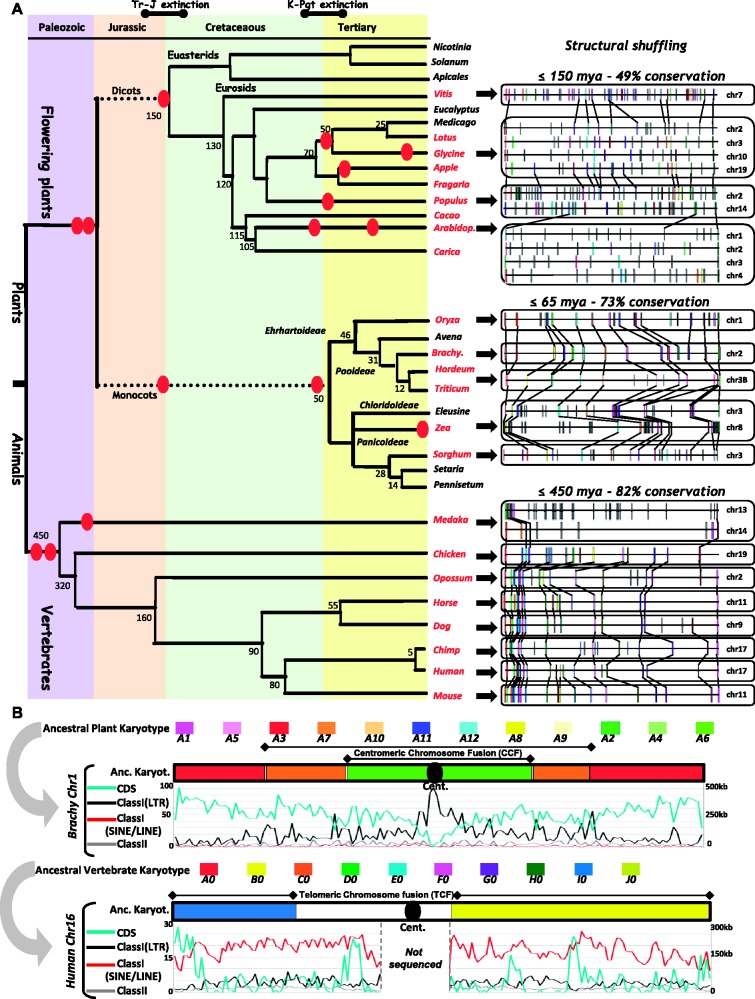
Gene conservation in plant and animal genomes. (A) A highly pruned phylogenetic tree of the plants and animals is shown at the left end side of the figure with speciation dates of the branches (in millions years) and duplication events highlighted as red dots. Micro-synteny conservation is shown at the right end side of the figure with homologous genes in the same color code and connected with black lines. (B) Comparison of plant (Brachypodium chromosome 1) and animal (human chromosome 16) genome heat maps. Each chromosome structure is illustrated based on the ancestral karyotype (10 and 12 colour codes, respectively for animals and plants) and associated with corresponding CDS (blue), TE class I LTR (black), TE class I non-LTR (purple) and TE class II (gray) distribution curves. Within 500-kb-sized windows covering the entire considered chromosome, CDS distribution (left) represents the number of annotated genes and TEs distribution (right, Y-axis) represents the cumulative size in “Kb” covered by either class I (black curve) and class II (gray curve) elements.